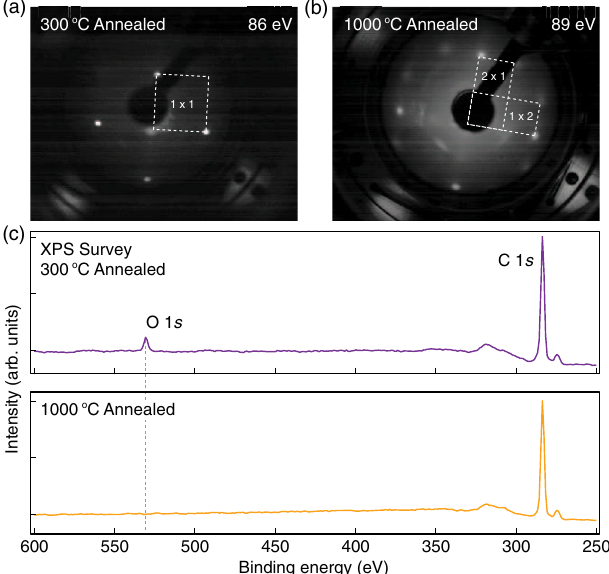
FIG. 14. (a) LEED of an oxygen-annealed surface, as shown in Fig. 3(c). The 1 × 1 reconstruction is consistent with an ether- terminated surface. (b) LEED after in situ annealing at 1000 °C showing 2 × 1 reconstruction peaks that appear for the same surface after the surface heteroatoms are removed. (c) XPS survey data showing that the O 1 s peak indeed disappears after annealing at 1000